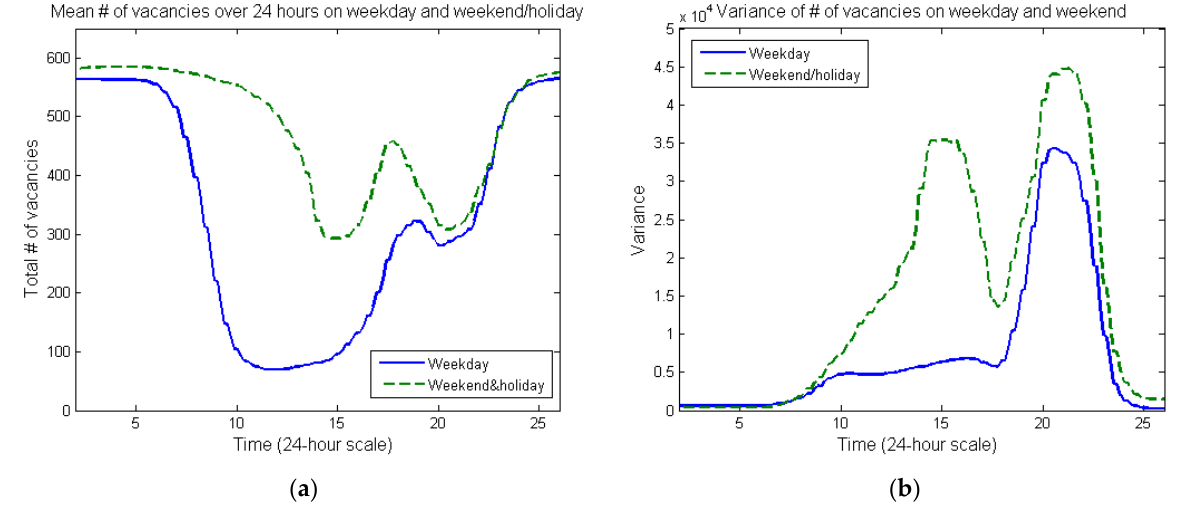
Figure 2. ( a ) Mean of the number of vacancies (out of the total 785); ( b ) variance of the number of vacancies.